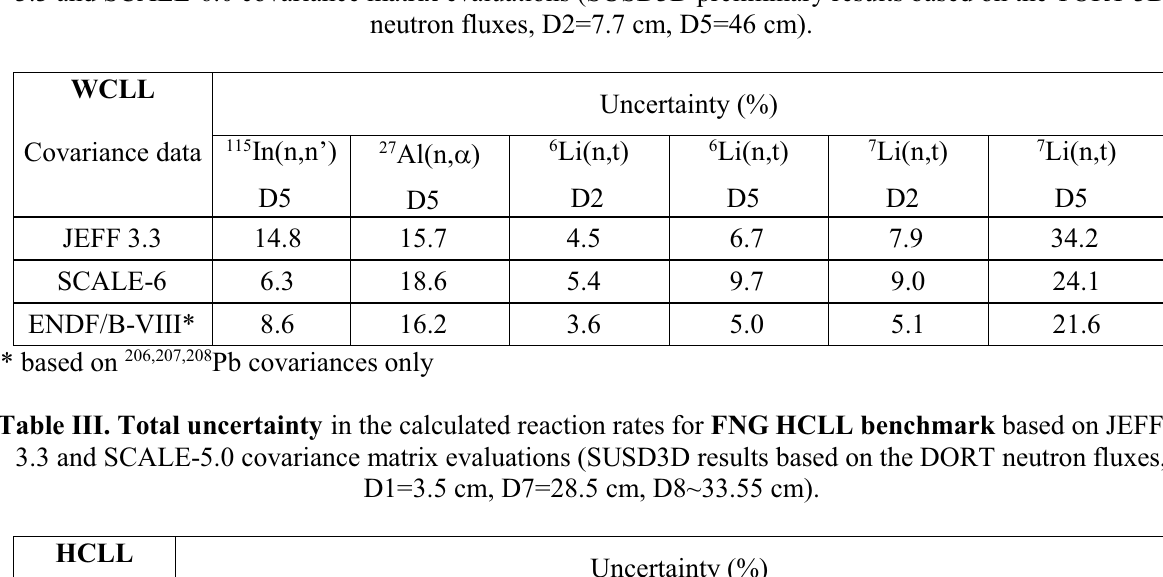
Table II. Total uncertainty in the calculated reaction rates for FNG WCLL benchmark based on JEFF- 3.3 and SCALE-6.0 covariance matrix evaluations (SUSD3D preliminary results based on the TORT 3D